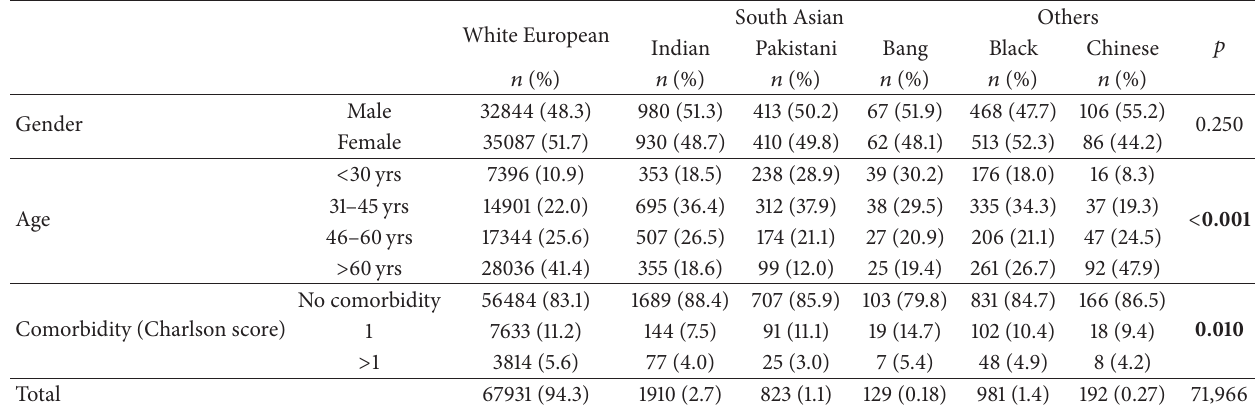
Table 1: Patient demographics for patients with UC admitted to hospitals in England between 1997 and 2012.